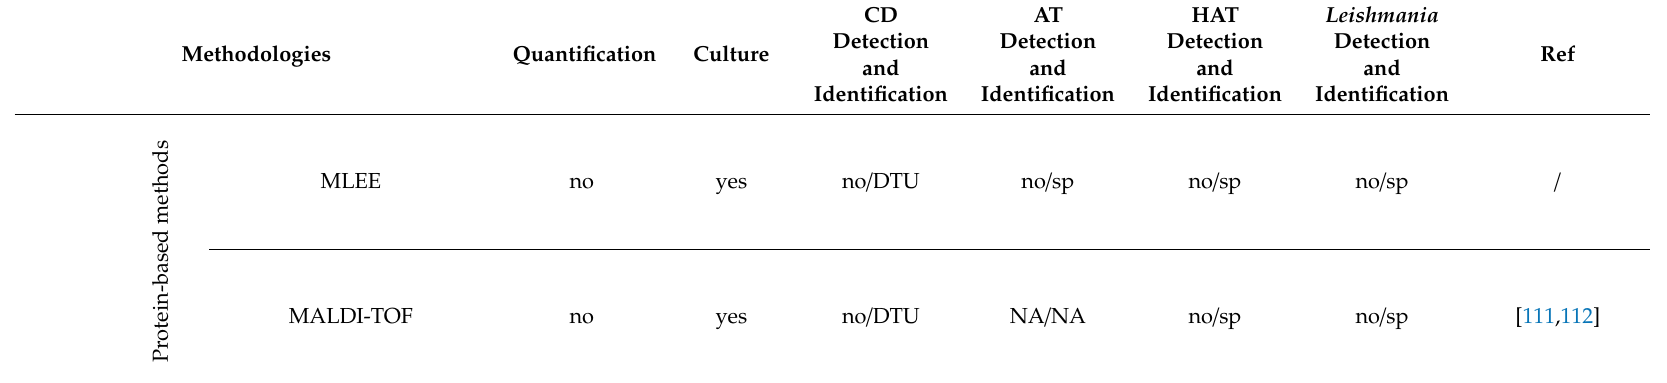
Methodologies Quantification Culture